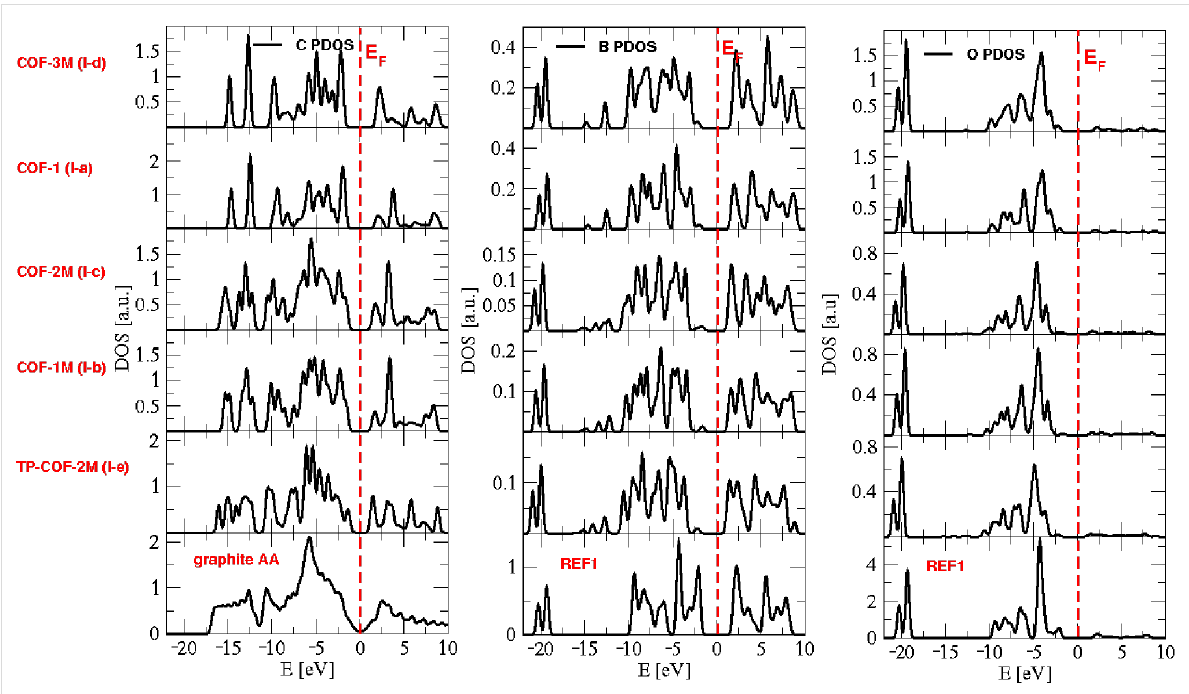
Figure 7: Partial density of states of carbon (left), boron (center), and oxygen (right) atoms of COFs built from type-I connectors and different linkers. The vertical dashed line in each figure indicates the Fermi level E F.